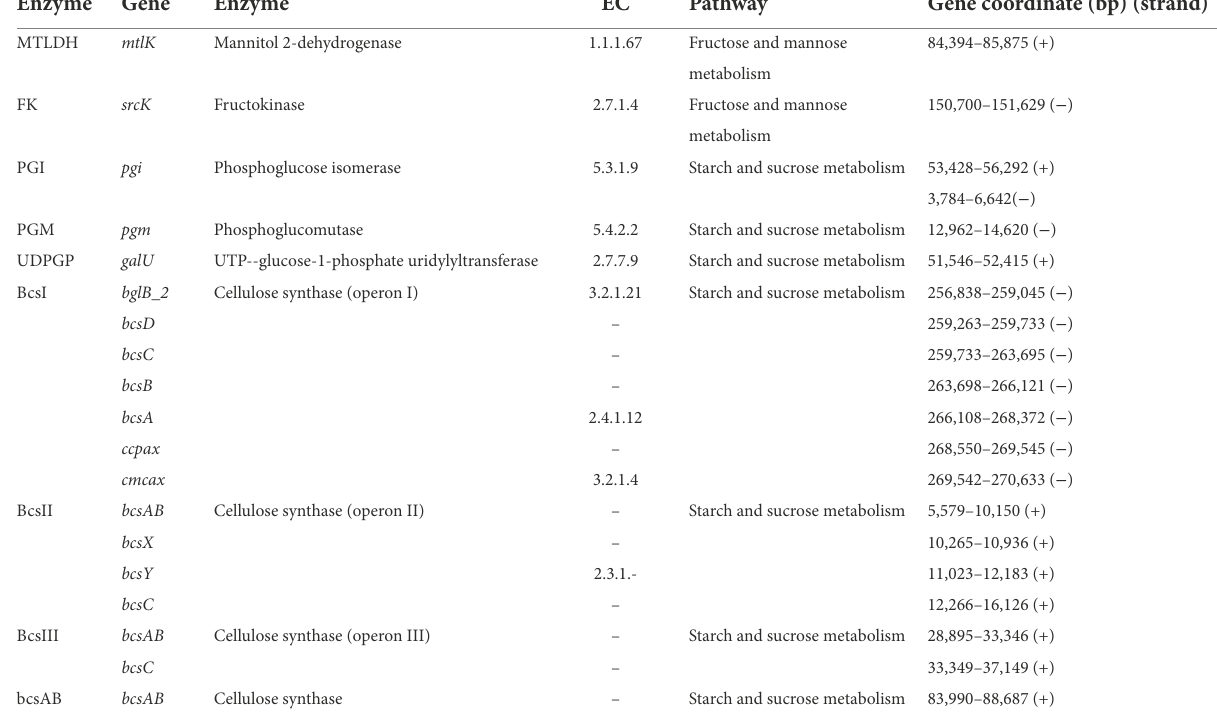
TABLE 2 Metabolic pathway of mannitol metabolism for the biosynthesis of BC.